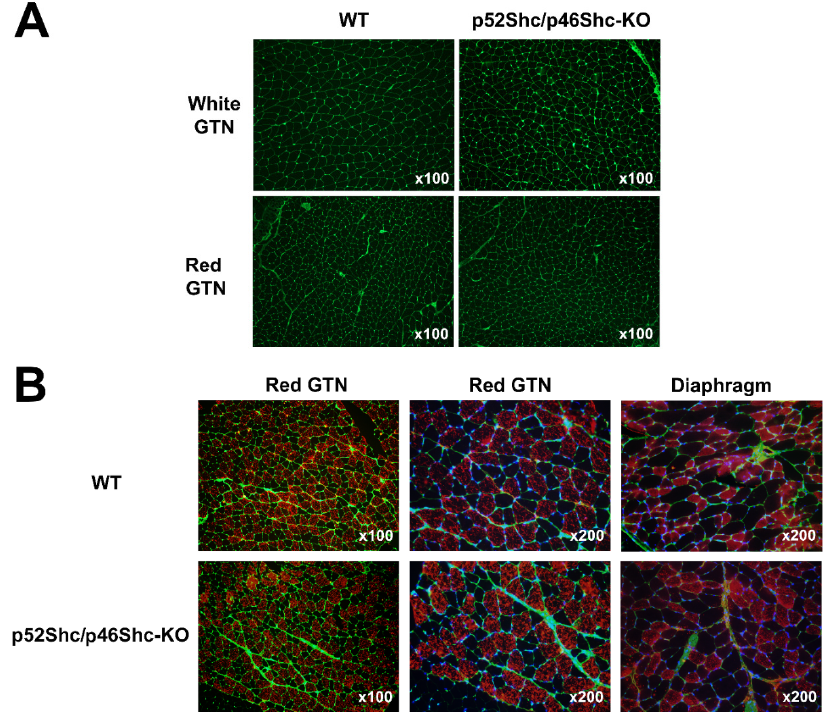
Figure 4. Comparison of GTN muscle and diaphragm morphology and fiber type composition of p52Shc/p46Shc-KO rats and WT littermates. ( A ) Cross-sections of white (glycolytic) and red (oxidative) areas of GTN muscle stained with WGA-fluorescein (green staining) are presented. ( B ) Cross-sections of red (oxidative) areas of GTN muscle and diaphragm stained with anti-slow MHC antibody (red staining) and WGA-fluorescein (green staining) are presented. DAPI (blue staining) was used to visualize nuclei.